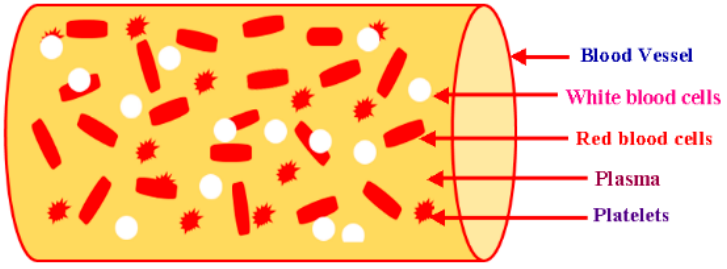
Figure 2. Blood and its components.